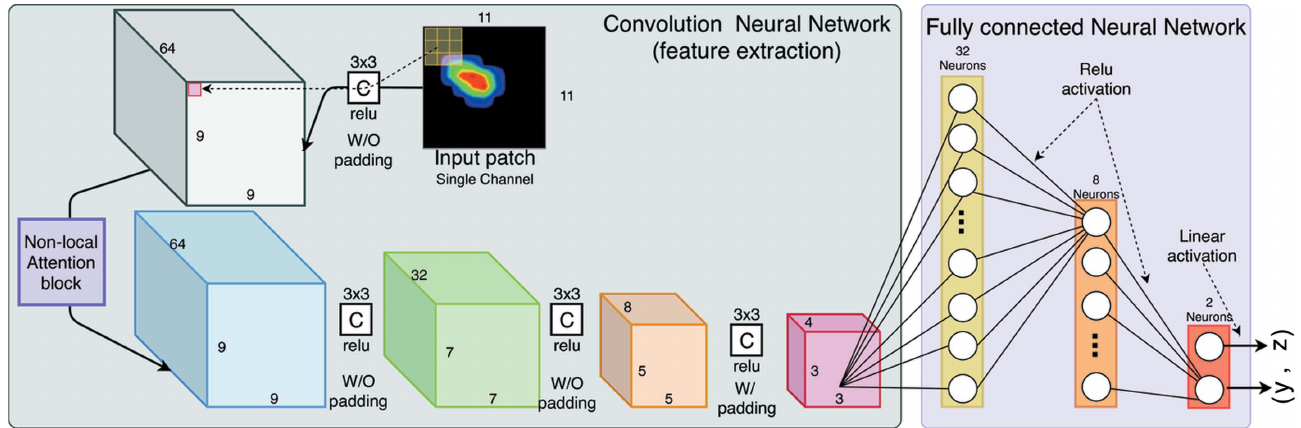
Figure 2 Application of the BraggNN deep neural network to an input patch yields a peak center position ( y , z ). All convolutions are 2D of size 3 (cid:3) 3, with a rectifier activation function. Each fully connected layer, except for the output layer, also has a rectifier activation function. The non-local attention block will be discussed in Appendix